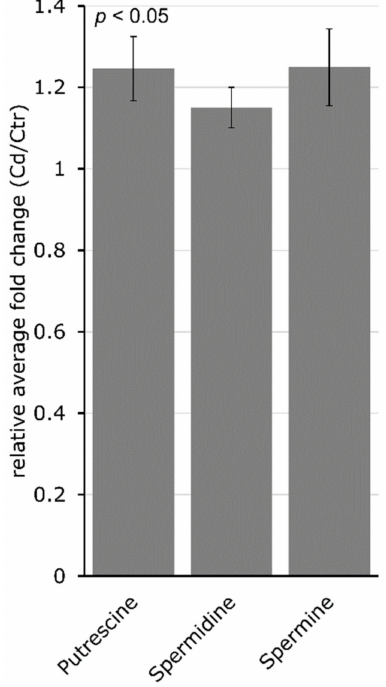
Figure 5. Long-term Cd exposure significantly changes the polyamine content in M. sativa stems. Relative average fold-change ± SEM ( n = 5). Polyamine content was measured using HPLC-FLD. Significance of fold change was determined with a Student’s t -test at p <